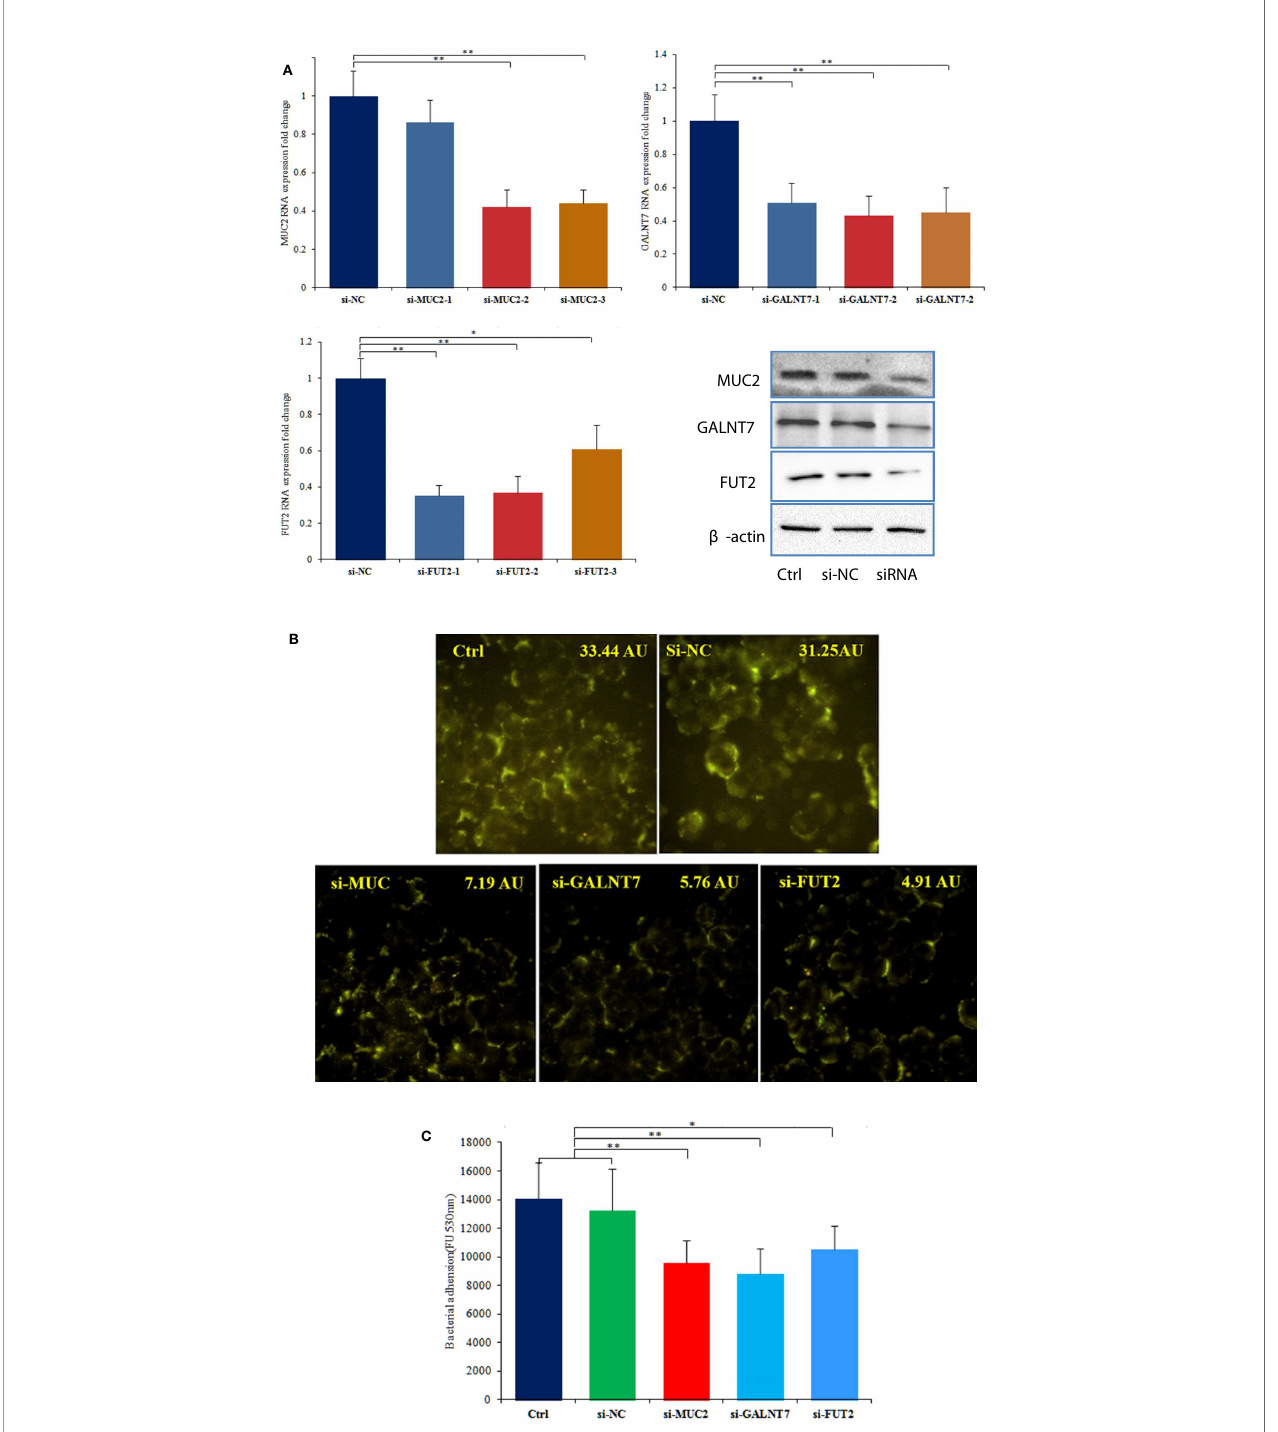
FIGURE 3 | Knockdown of MUC2, GALNT7 or FUT2 decreased the adhesion of C. butyricum to HT-29 cells. n=3. (A) Knockdown ef fi ciencies of MUC2, GALNT7 and FUT2 were examined by RT-qPCR in HT29 cells, and then western blot analysis was performed to verify the knockdown ef fi ciencies. (B) After knockdown of MUC2, GALNT7 or FUT2, HT-29 cells were stained with FITC labeled agglutinin. The mean fl uorescence intensity of each picture is 33.44, 31.25, 7.19, 5.76, 4.91 arbitrary units (AU) using ImageJ software. (C) Adhesion of C. butyricum to HT-29 cells was assayed by measure of the fl uorescence intensity with the microplate reader at 528 nm. The si-MUC2-2, si-GALNT7-2 and si-FUT2-1 were used in this adhesion experiment. Results are expressed as means and standard deviation of three independent experiments with ** P < 0.01 and * P <